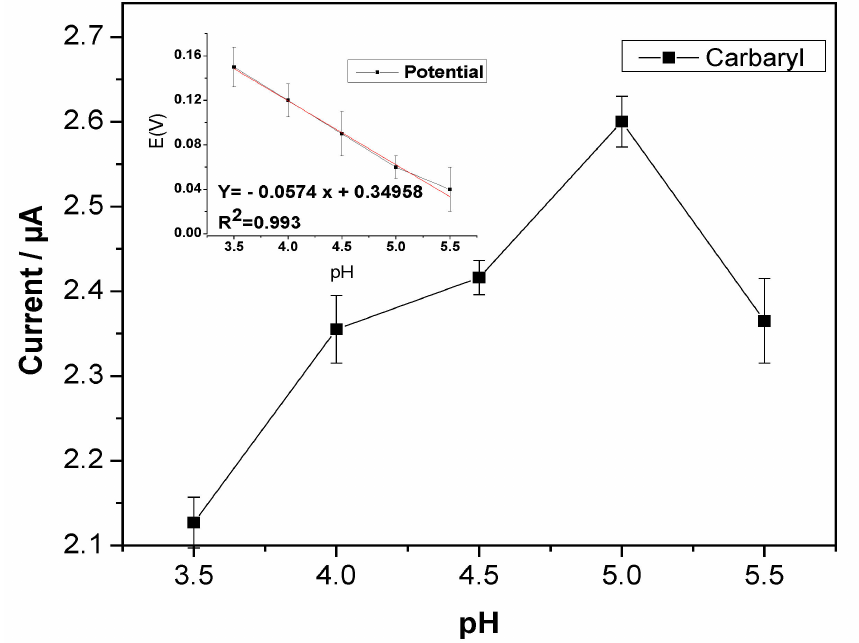
Figure 8. The effect of pH of 0.1 M sodium acetate buffer on the oxidation current and potential of 200 µ M carbaryl at rGO/AuNP/NA